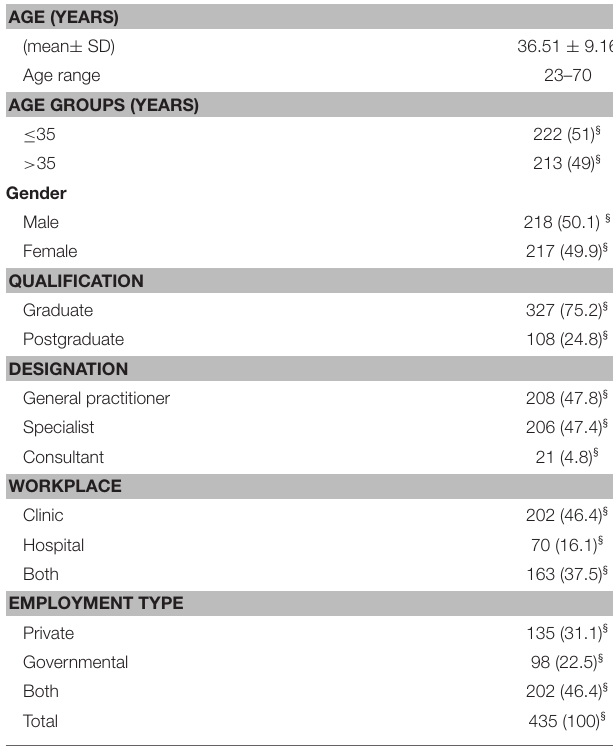
TABLE 2 | Demographic characteristics of the study